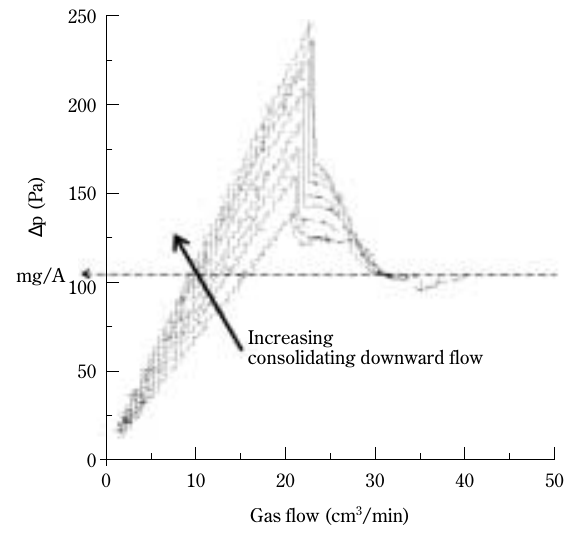
Gas pressure drop versus gas flow for a given mass of xerographic toner (with 0.05%wt of silica) previously con- solidated with a downward-directed gas flow. Curves in the left-hand direction correspond to increasing values of the compressing gas flow and hence to increasing values of the consolidation stress s c .